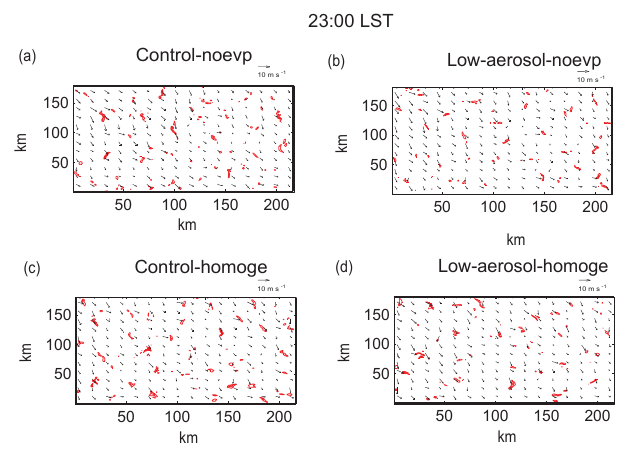
Figure 13. Spatial distributions of convergence (red contours) and wind vector (arrows) at the surface at 23:00LST. Panels (a) , (b) , (c) , and (d) are for the control-noevp run, the low-aerosol-noevp run, the control-homoge run, and the low-aerosol-homoge run, respectively, and contours are at 2.1 and 3 . 5 × 10 − 2 s − 1 .